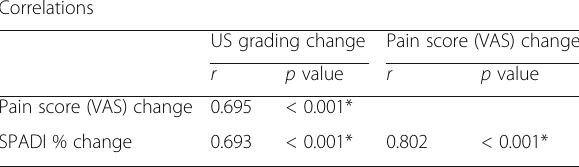
Table 4 Correlations between US grading changes with other variables and correlation between VAS score change and SPADI